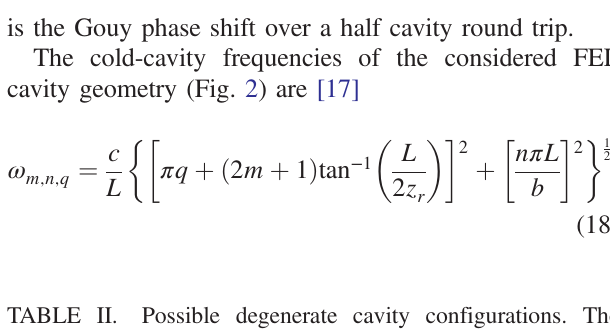
TABLE II. Possible degenerate cavity configurations. The cavity length is 7.5 m.